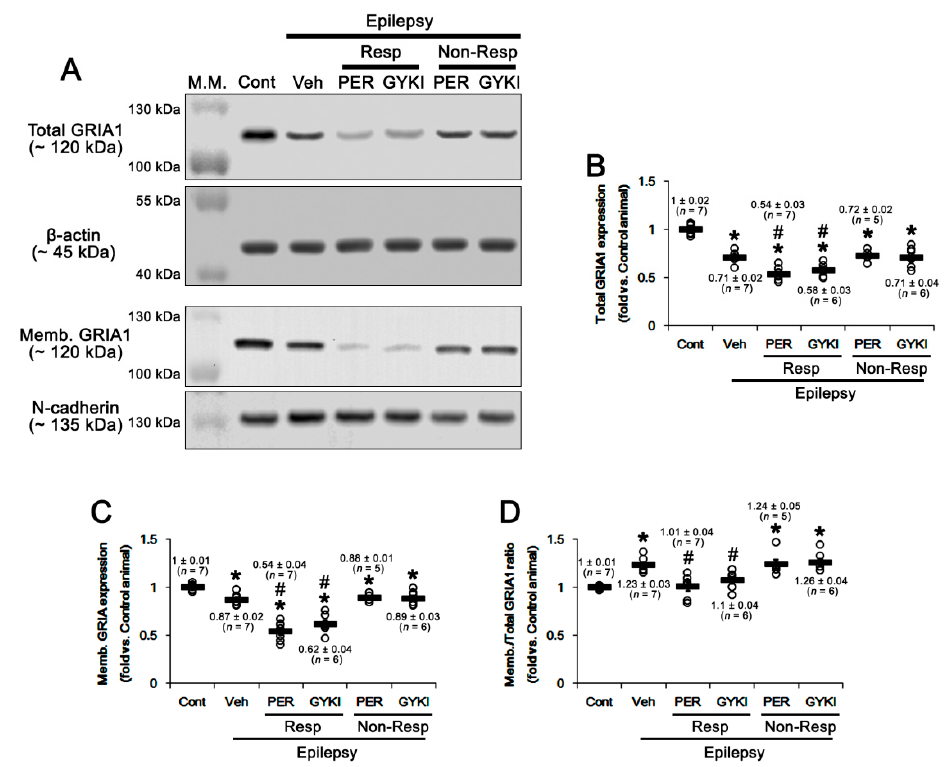
Figure 7. The effects of perampanel (PER) and GYKI 52,466 (GYKI) on total glutamate ionotropic receptor AMPA type subunit 1 (GRIA1) and its surface expression level in chronic epilepsy rats. Both AMPAR antagonists reduce total- and membrane GRIA1 expression in responders (Resp), but not non-responders (Non-Resp). ( A ) Representative images for Western blot of total- and membrane GRIA levels in the hippocampal tissues. ( B – D ) Quantifications of total GRIA1 ( B ), membrane GRIA1 ( C ), and membrane (memb.) / total GRIA1 ratio ( D ) levels in the hippocampal tissues. Open circles indicate each individual value. Horizontal bars indicate mean value. Error bars indicate SEM ( * , # p < 0.05 vs. control and vehicle (Veh)-treated animals, respectively; one-way ANOVA with post hoc Bonferroni’s multiple comparison).